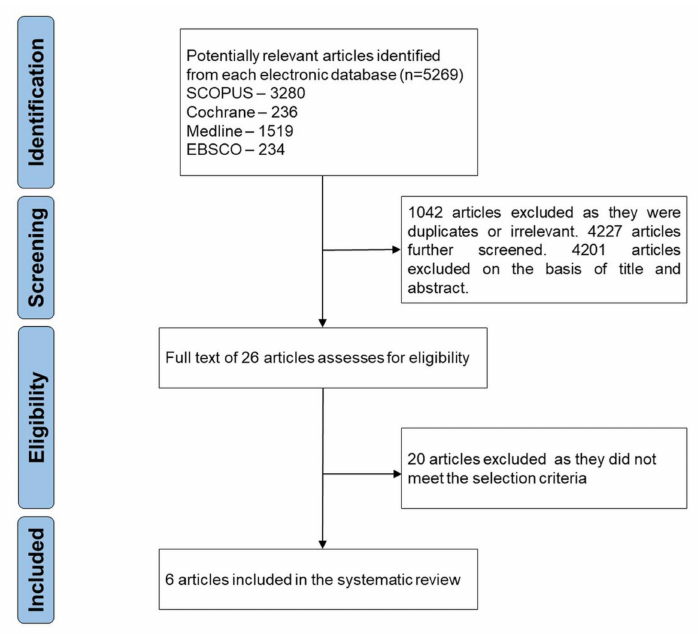
Figure 1. PRISM flow chart of the study selection.